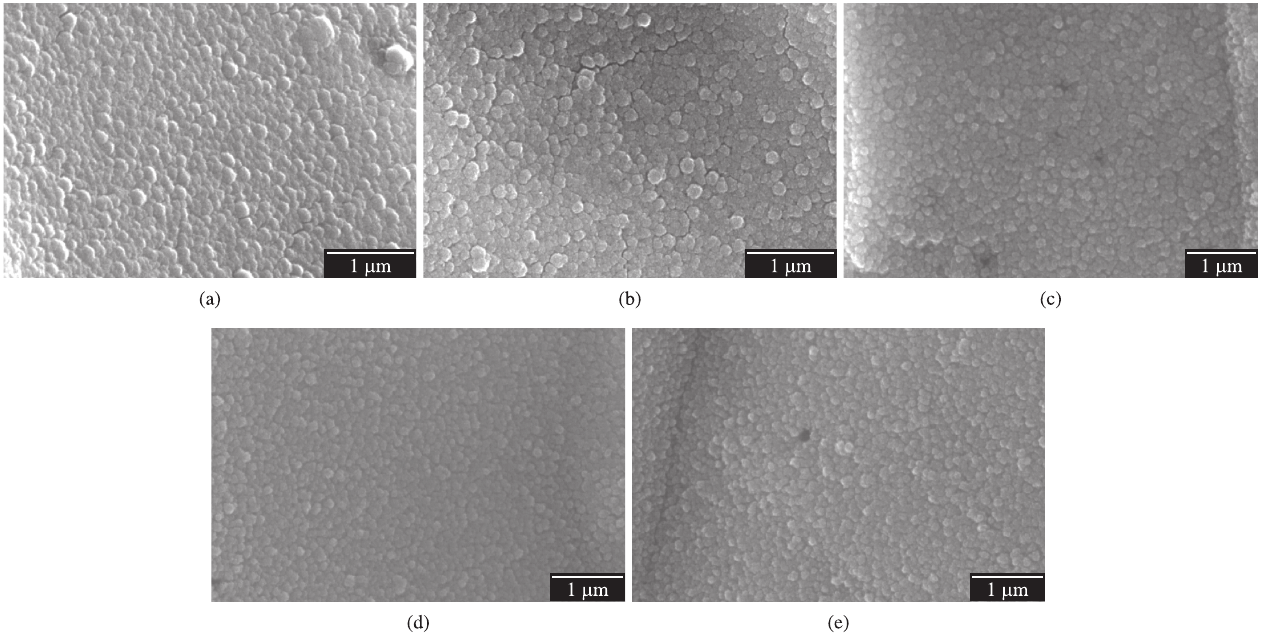
Figure 2. SEM micrographs of the fracture surfaces of the microwave hybrid fast sintered 2 g sample sintered for 30 minutes: a) near-surface region; b) interior region and of the microwave hybrid fast sintered 14 g sample sintered for 40 minutes; c) near-surface region; d) interior region; and e) center